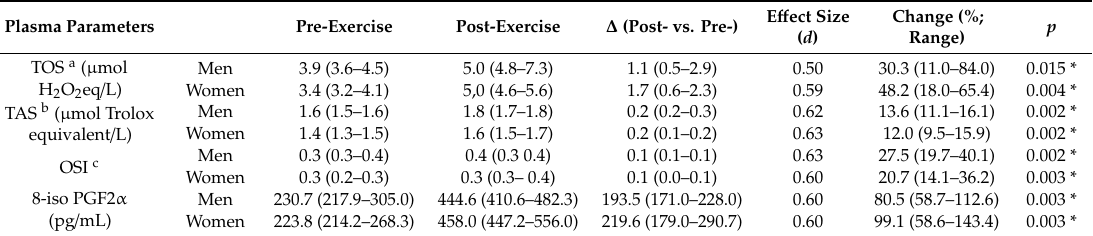
Table 2. Plasma oxidative stress parameters before and after the exercise protocol.